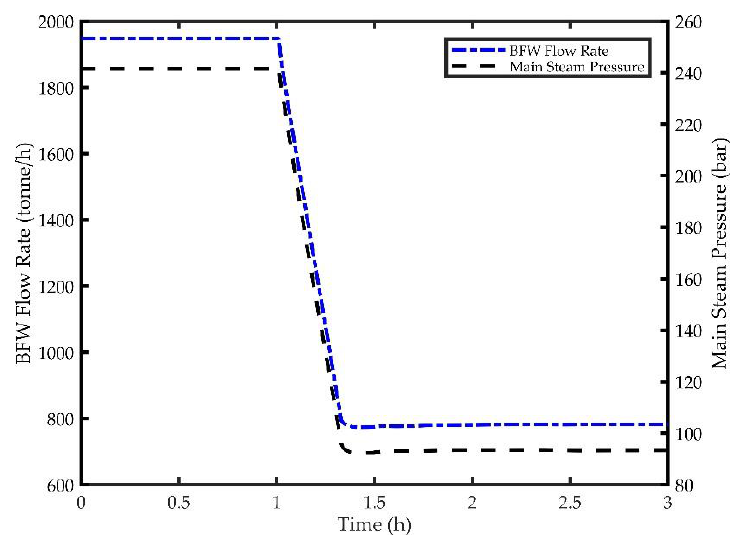
Figure 12. Response of BFW Flowrate and Main Steam Pressure to a 60% Reduction in Load. Processes 2018 , 6 , x FOR PEER REVIEW